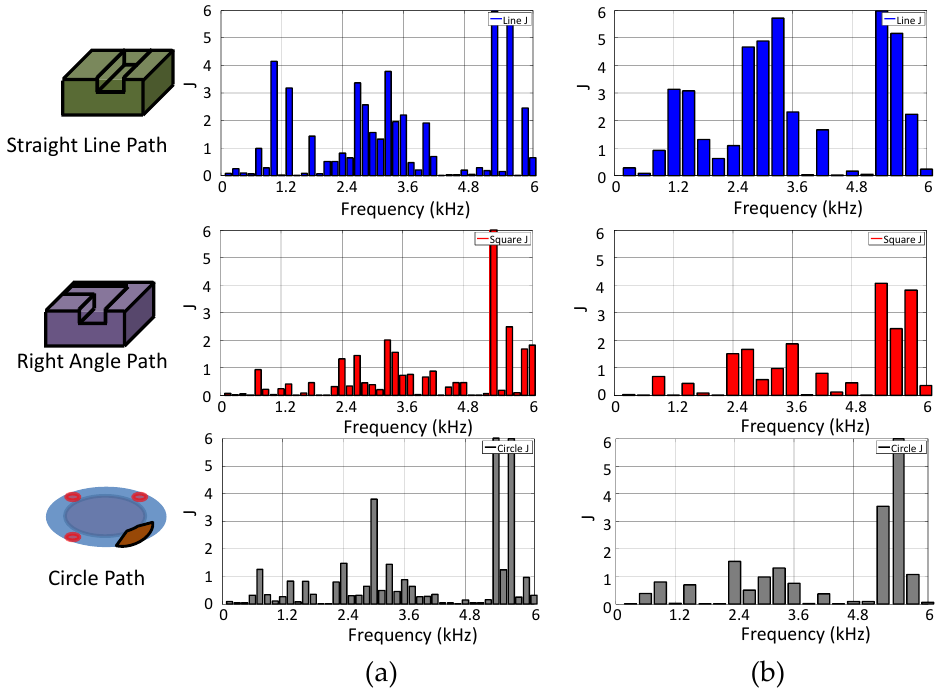
Figure 16. Classification index J with various bandwidth sizes: ( a ) 150 Hz; ( b ) 300 Hz (X-direction).